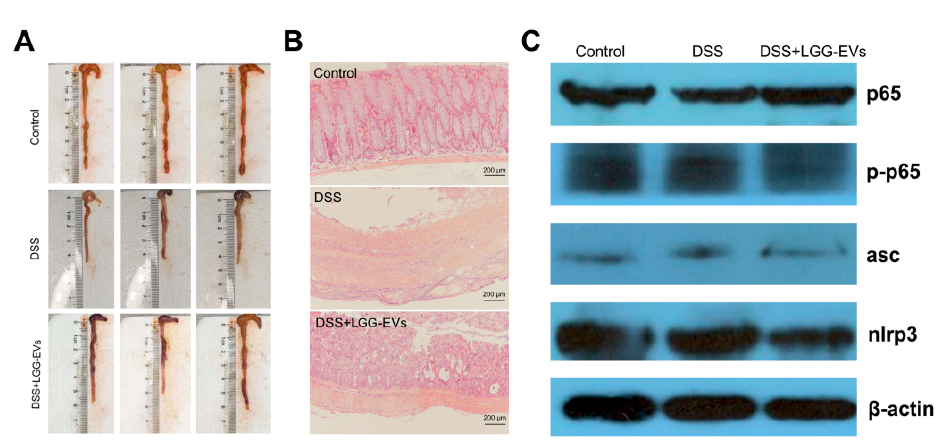
Figure 2. LGG-EVs alleviated DSS-induced colitis. ( A ) LGG-EVs treatment prevented the shortening of colon length in colitis mice. ( B ) Representative images of colonic sections stained with H&E for histopathologic evaluations. ( C ) Effect of LGG-EVs on NF- κ B and NLRP3 signaling pathways involved in DSS-induced UC.